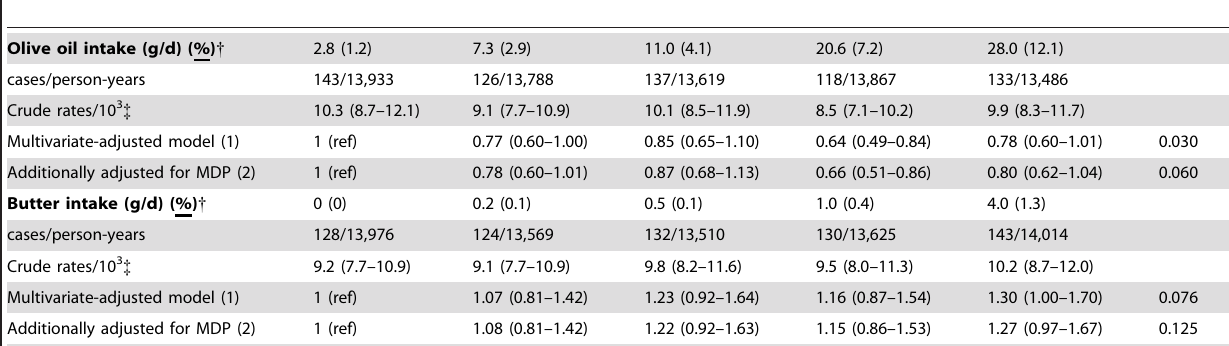
Table 2. Association between culinary fats consumption (quintiles: Q1 to Q5) and depression*. Olive oil intake (g/d) (%) {